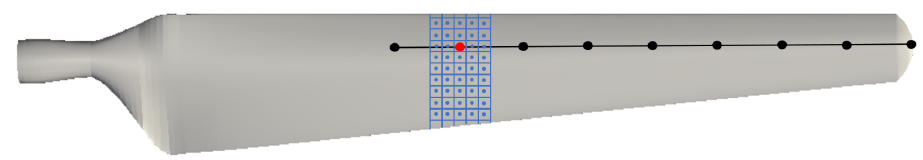
Figure 1. Principle of gradient projection for a wind turbine rotor